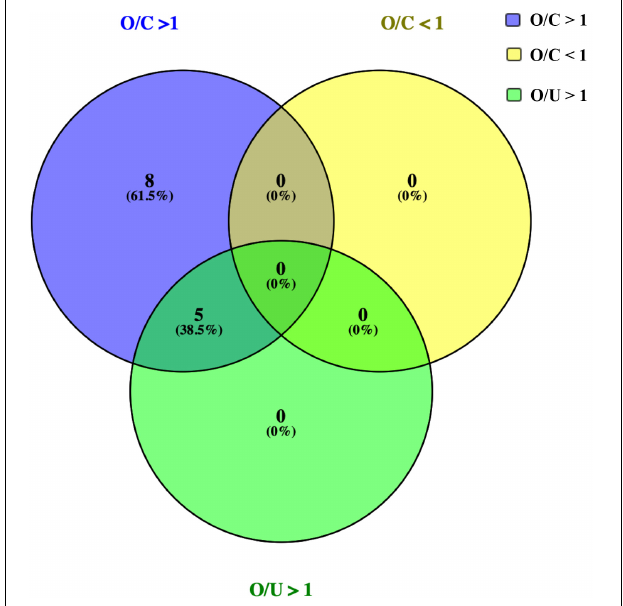
FIGURE 1 | Venn diagram showing the numbers and overlap of cytokines analyzed in the 3 groups. Expressions of 13 cytokines were increased significantly in the OT group than those in the control group (O/C > 1), including TNF-a, IFN-a2, IL-4, IL-5, IL-6, IL-9, IL-10, IL-13, sCD40L, PDGF-AA, PDGF-AB/BB, FLT3l, and EGF. Among them, 5 cytokines, including IL-5, IL-9, IL-10, IL-13, and PDGF-AA, were increased significantly in OT group, if compared with those in non-OT group (O/U > 1). No significant decrease of cytokines was identified in OT group, when compared with those in control/non-OT